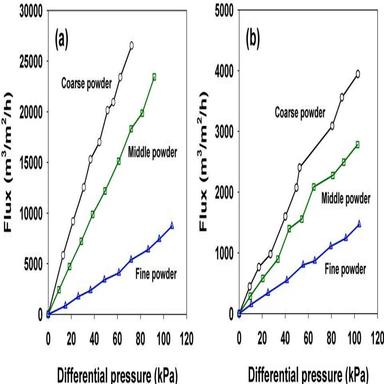
The air (N2) permeability of matrix and porous membrane of samples fabricated by different powders sintered at 1000 ℃ with the pressure of 30 kPa.